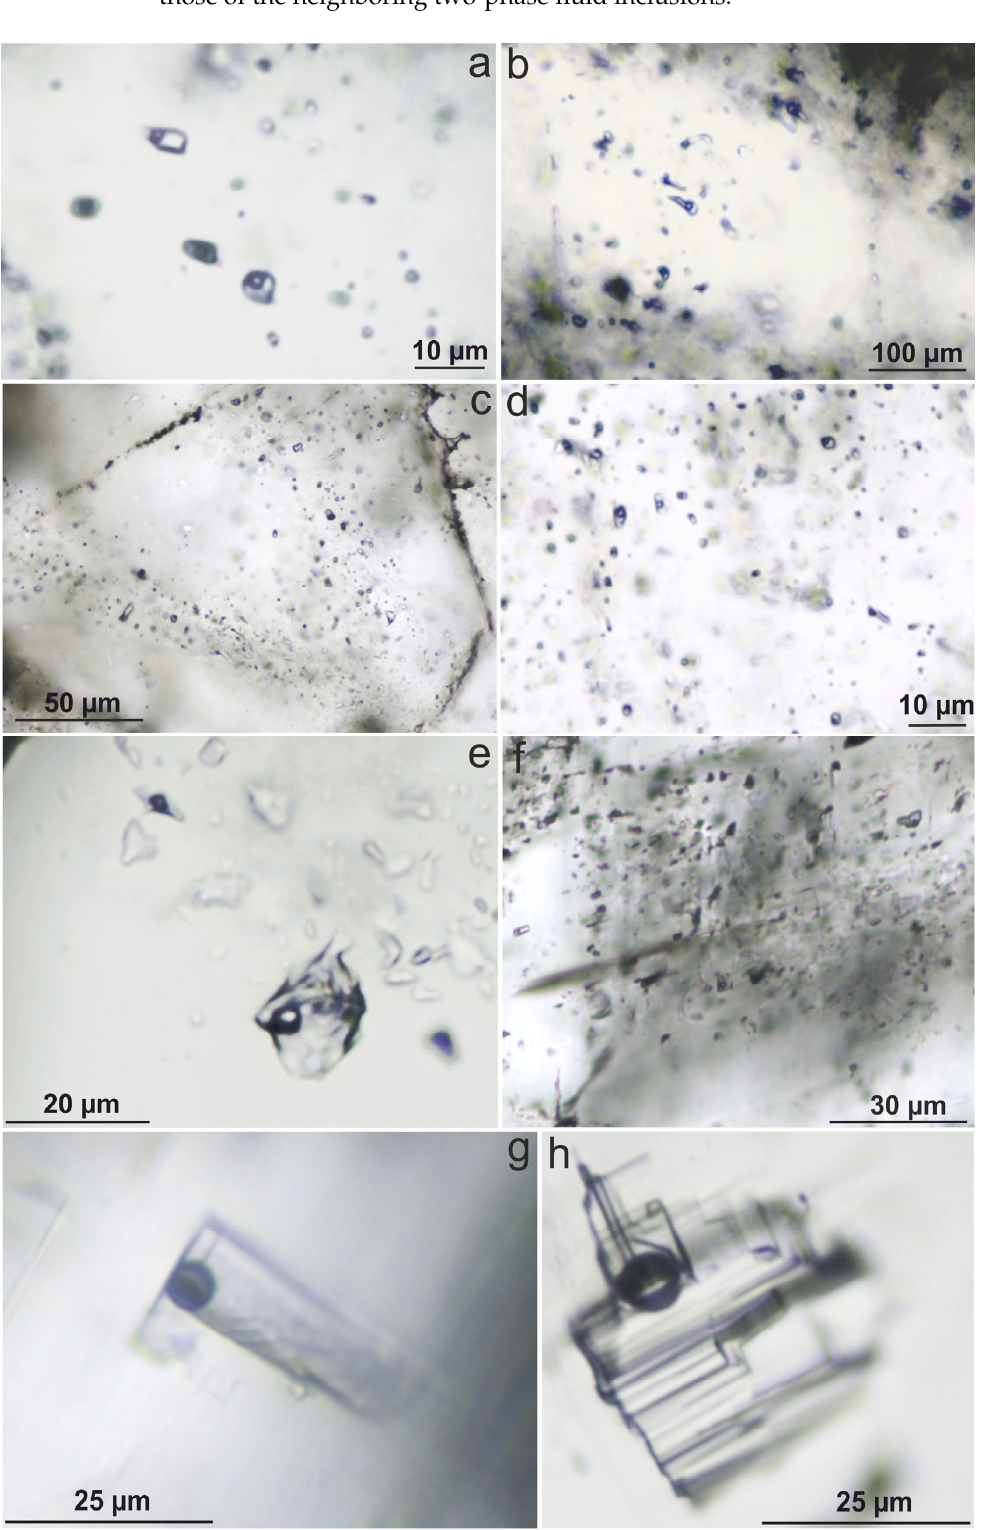
Figure 24. Examples of fluid inclusions from quartz Q-2 ( a – c ), quartz Q-3 ( d ), quartz Q-4 ( e ), dolomite ( f , g ), and calcite ( h ) from the studied gold-bearing vein.